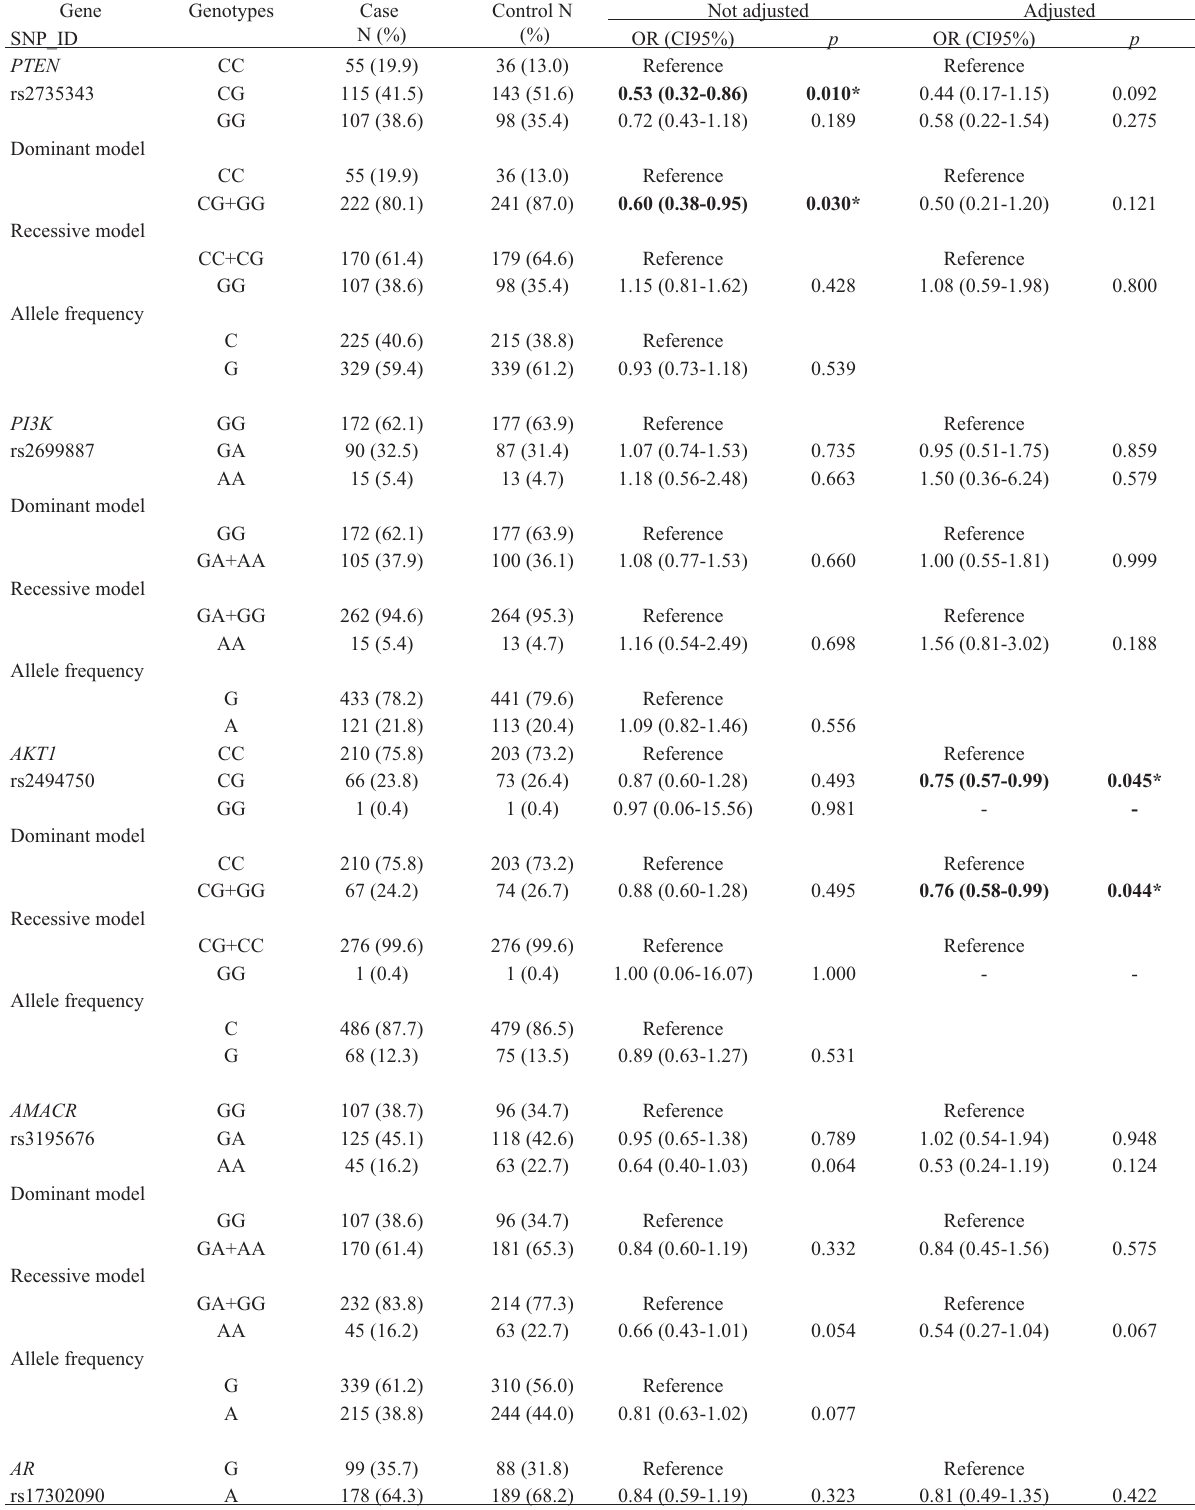
Table 2 - Univariate and multivariate regression analysis of genotypes and allele of PTEN , AKT1 , PI3K , AR , and AMACR genes in controls and patients with prostate cancer.